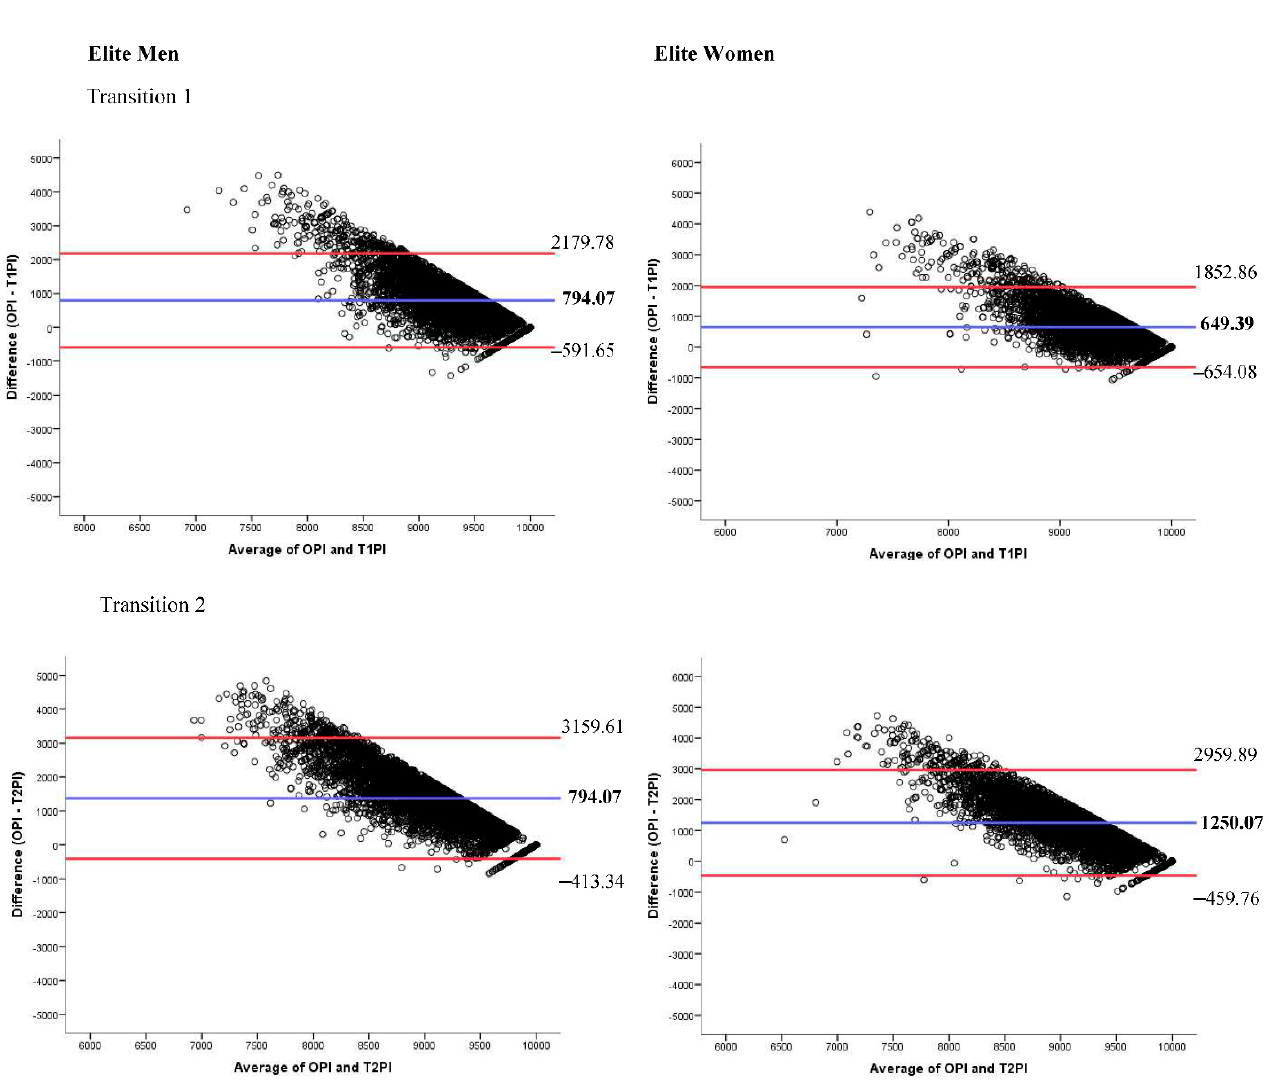
Figure 3. Bland–Altman plots between transition 1 performance indicator (T1PI) and transition 2 performance indicator (T2PI) and overall performance indicator (OPI). The red lines represent the upper and lower 95% limits of agreement, whereas the blue line represents the bias.